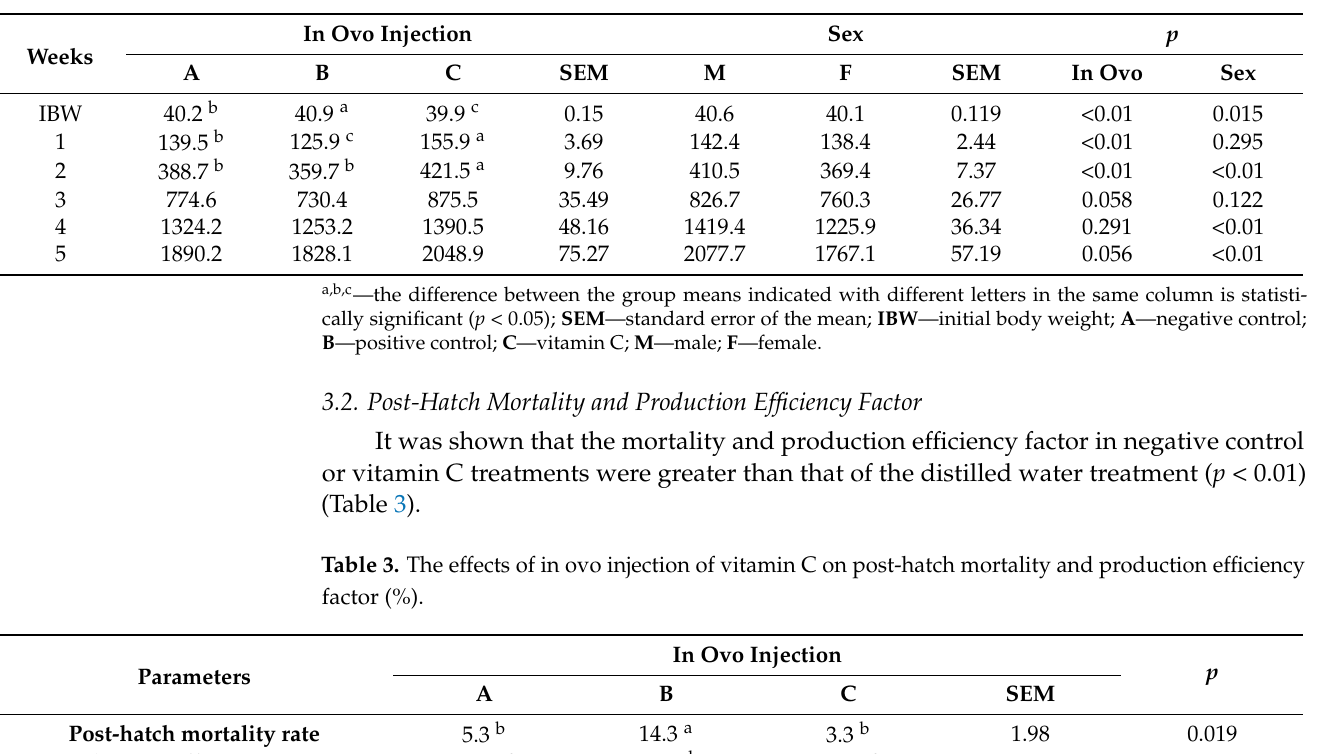
Table 2. The effects of in ovo injection of vitamin C and sex on body weight (g).